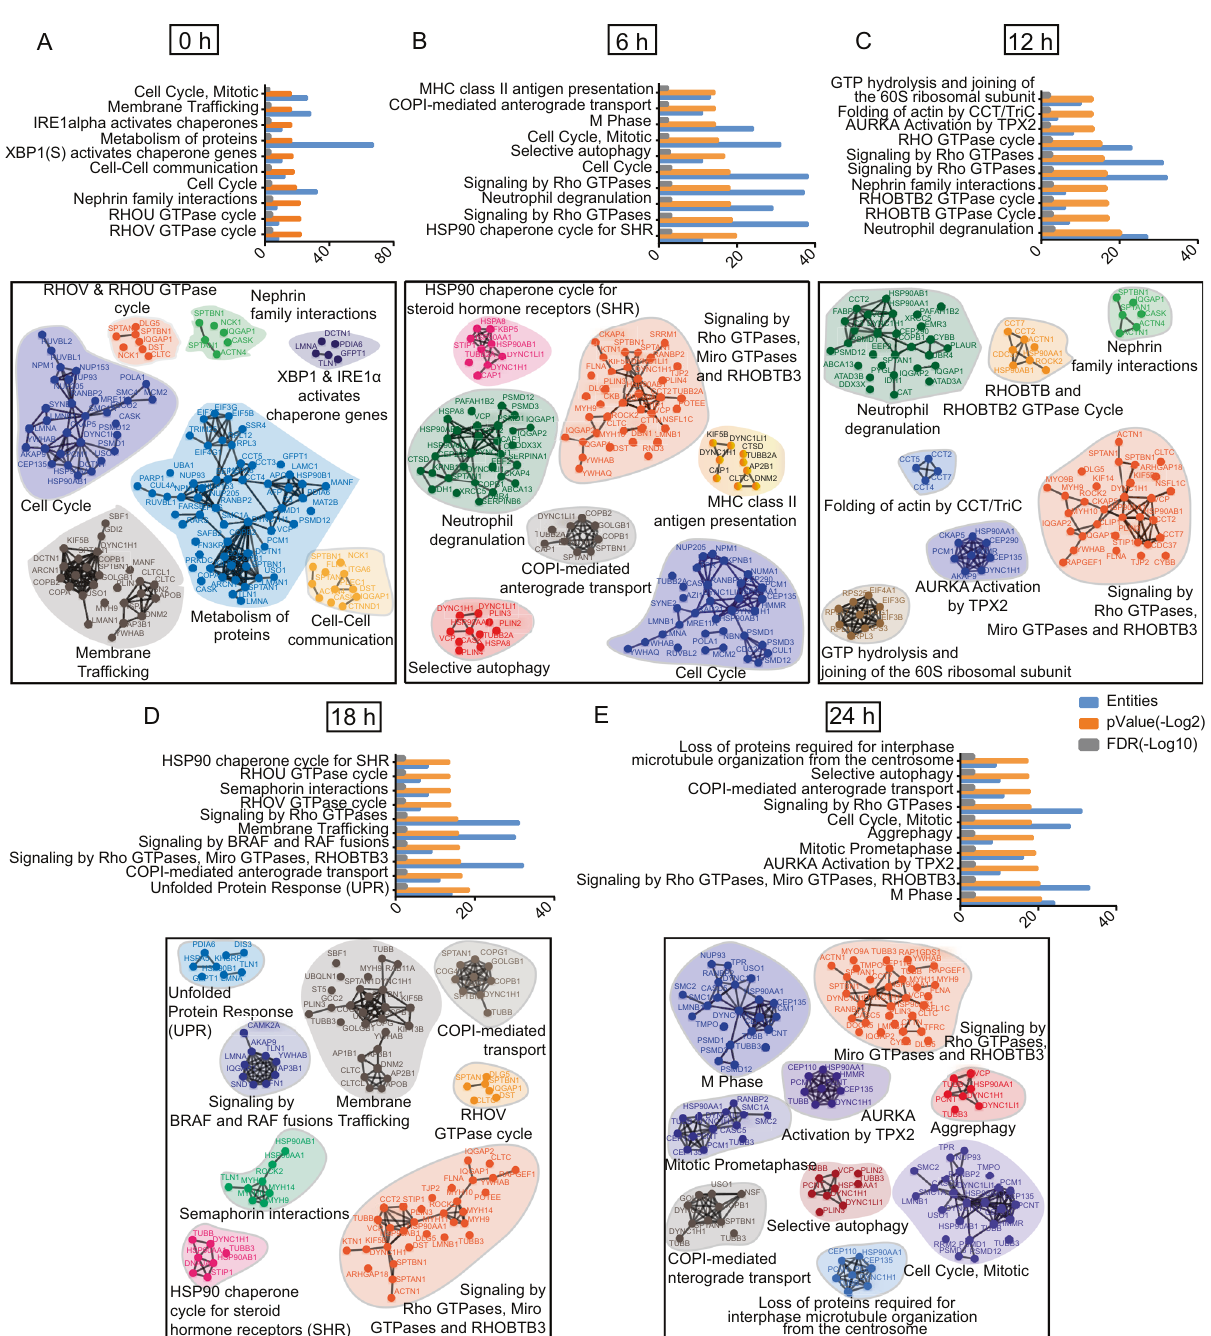
Fig. 6 Phosphoproteomics study also con fi rms PA-induced altered mitosis. Represented histogram showing top 10 enriched functional Reactome pathways that were arranged respective to their gene numbers, p value ( − Log2), and FDR( − Log10) ratio across the 0, 6, 12, 18, and 24 h time points (upper panel) ( A – E ). Schematic representations of the above-enlisted pathways corresponding to their linked phosphoproteins were highlighted. Each pathway was embedded with an associative PPI network generated from STRING with the highest con fi dence level (0.900). The colored domain represents individual pathways respective to their course of incubation time with PA (lower panel) ( A – E ). dependent cell death, a large cell population further entered the possible outcome of PA persuaded mitotic catastrophe. The into the early and late apoptosis as observed in our annexin V lethal proteins, such as BCL-2 family members Bax, Bid, and -FITC assay (Supplementary Fig. S1C, D). Therefore, we explored cleaved Cas3 and Cas9 were unchanged in the early time points caspase-independent death pathways where cells response to and their expression was signi fi cantly reduced after 24 h of PA intrinsic clues and evolve mitochondrial outer membrane exposure (Fig. 8A-C). The data suggested that PA-induced permeabilization, membrane potential loss, PARP activation HepG2 cell death is caspase as well as pro-apoptotic proteins and release mitochondrial apoptosis-inducing factor 1 (AIFM1) independent. Despite homeostatic suppression of caspase-